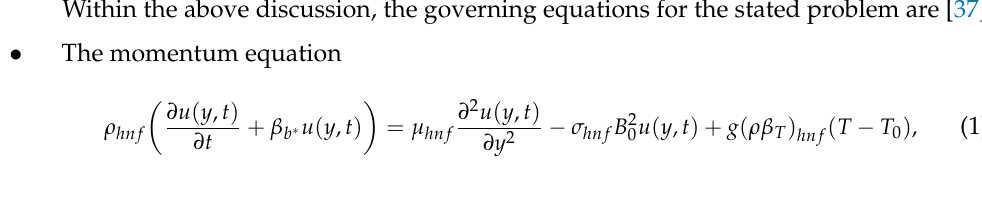
Figure 1. Flow geometry.